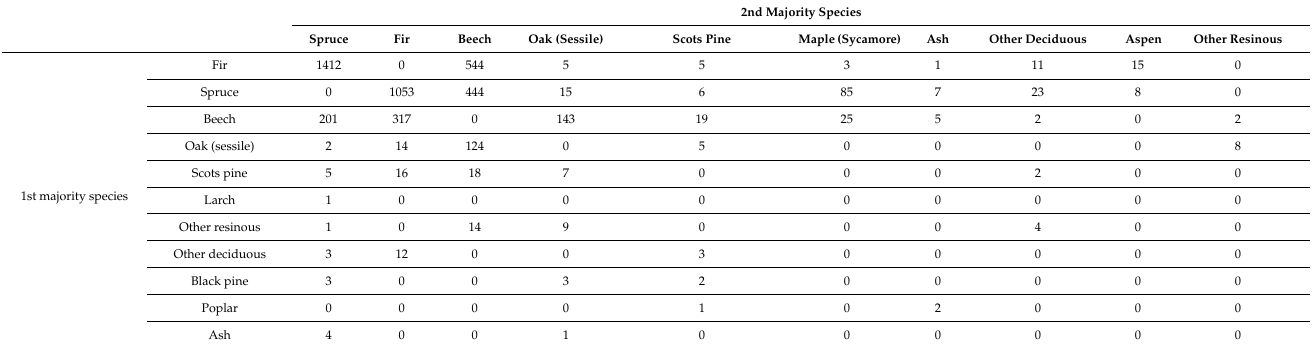
Table 1. Contingency table of couples (division, inventory year) according to the 1st and 2nd majority species (for simplicity of representation, the 2nd majority species that had less than 10 couples for all 1st majority species combined are not reported in this table).